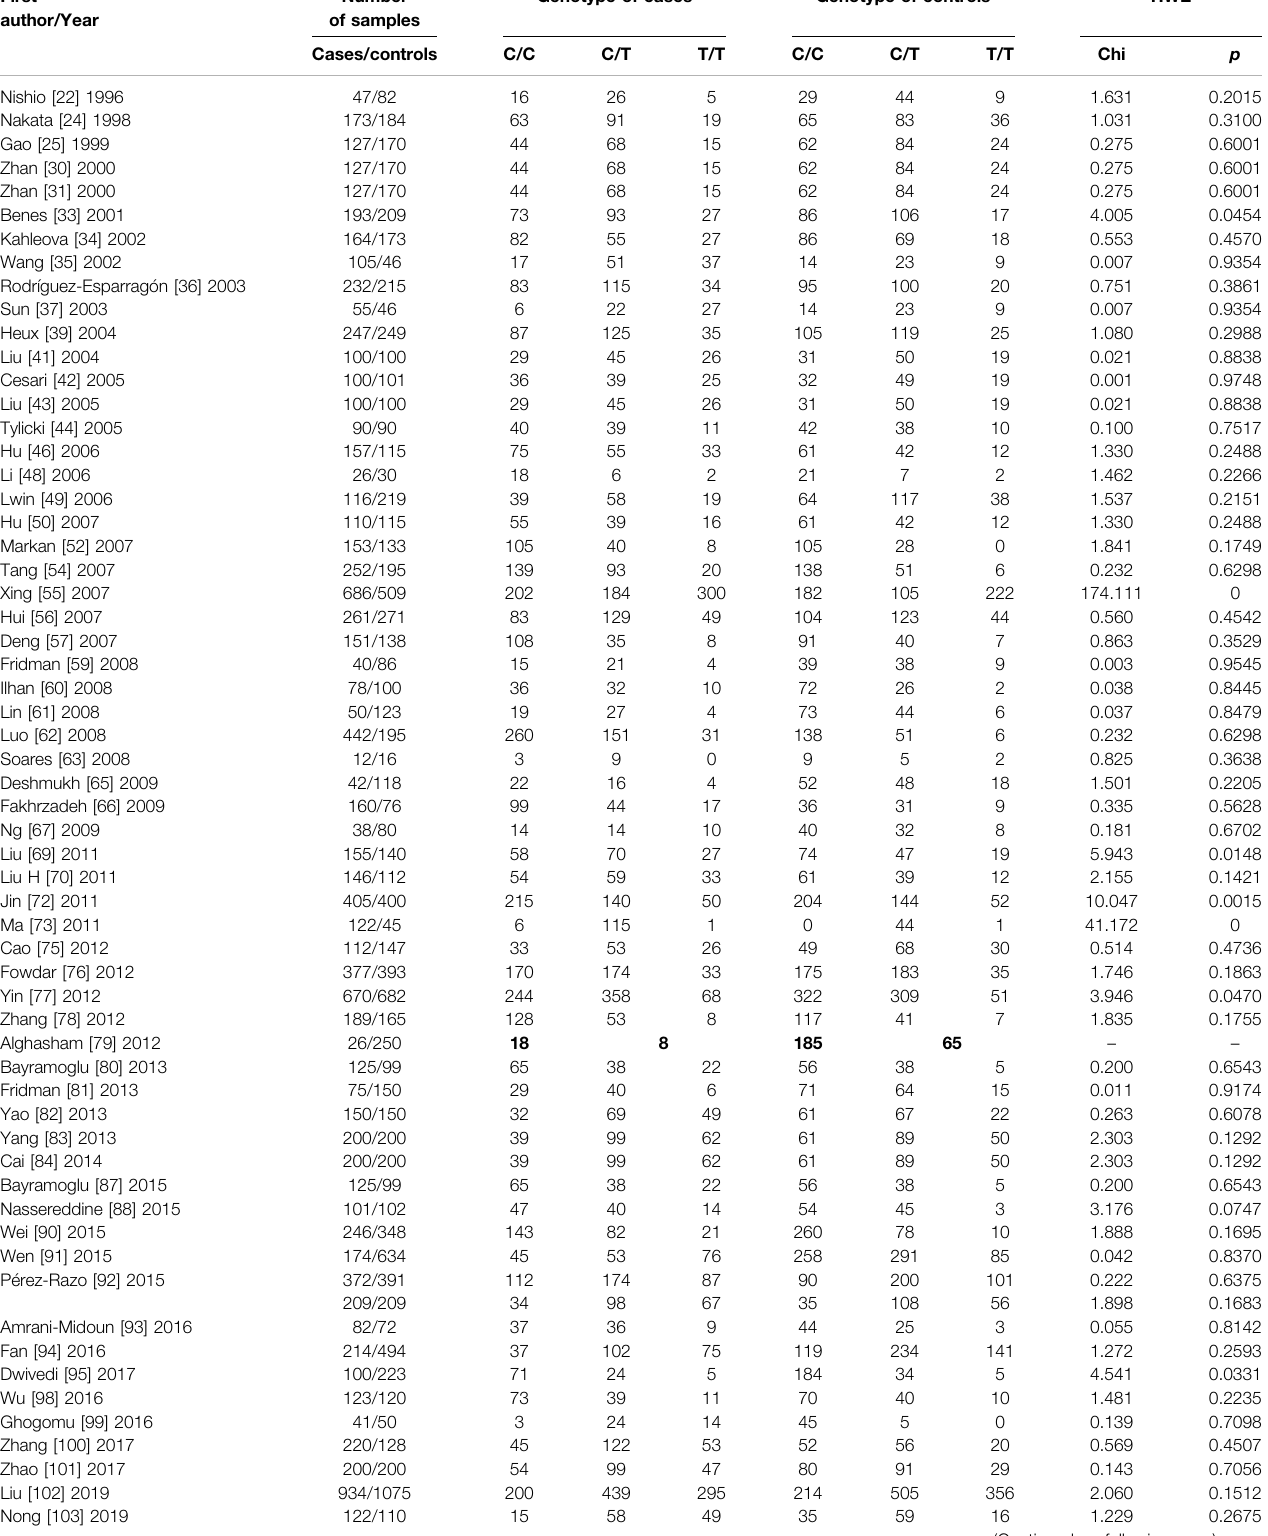
TABLE 3 | The genotype distribution and HWE of MTHFR C677T polymorphism in this meta-analysis. The bold value is C/T T/T A/C C/C genotype data is incomplete, and HWE evaluation cannot be